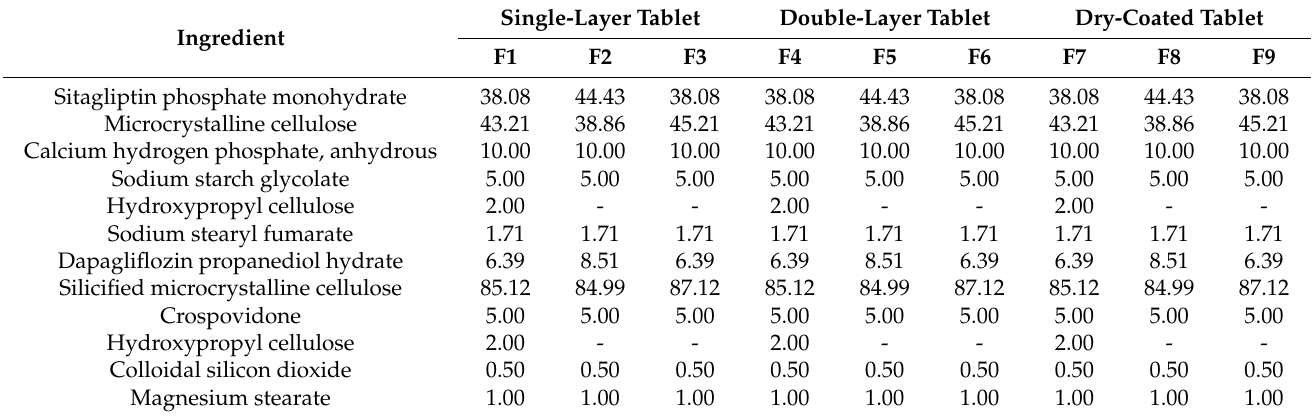
Table 1. Composition of sitagliptin phosphate monohydrate-dapagliflozin propanediol hydrate FDC tablets ( w / w